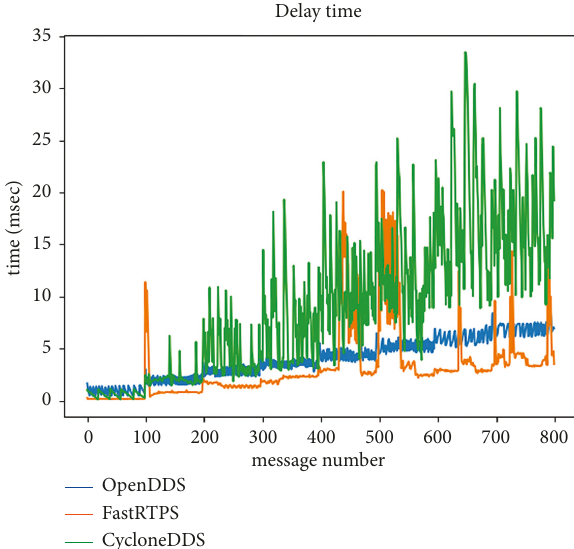
Figure 2: Qpid’s and RabbitMQ’s delay in the case of increasing the payload size every 100 messages. Figure 1: OpenDDS’s, FastRTPS’s, and Cyclone’s delay in the case